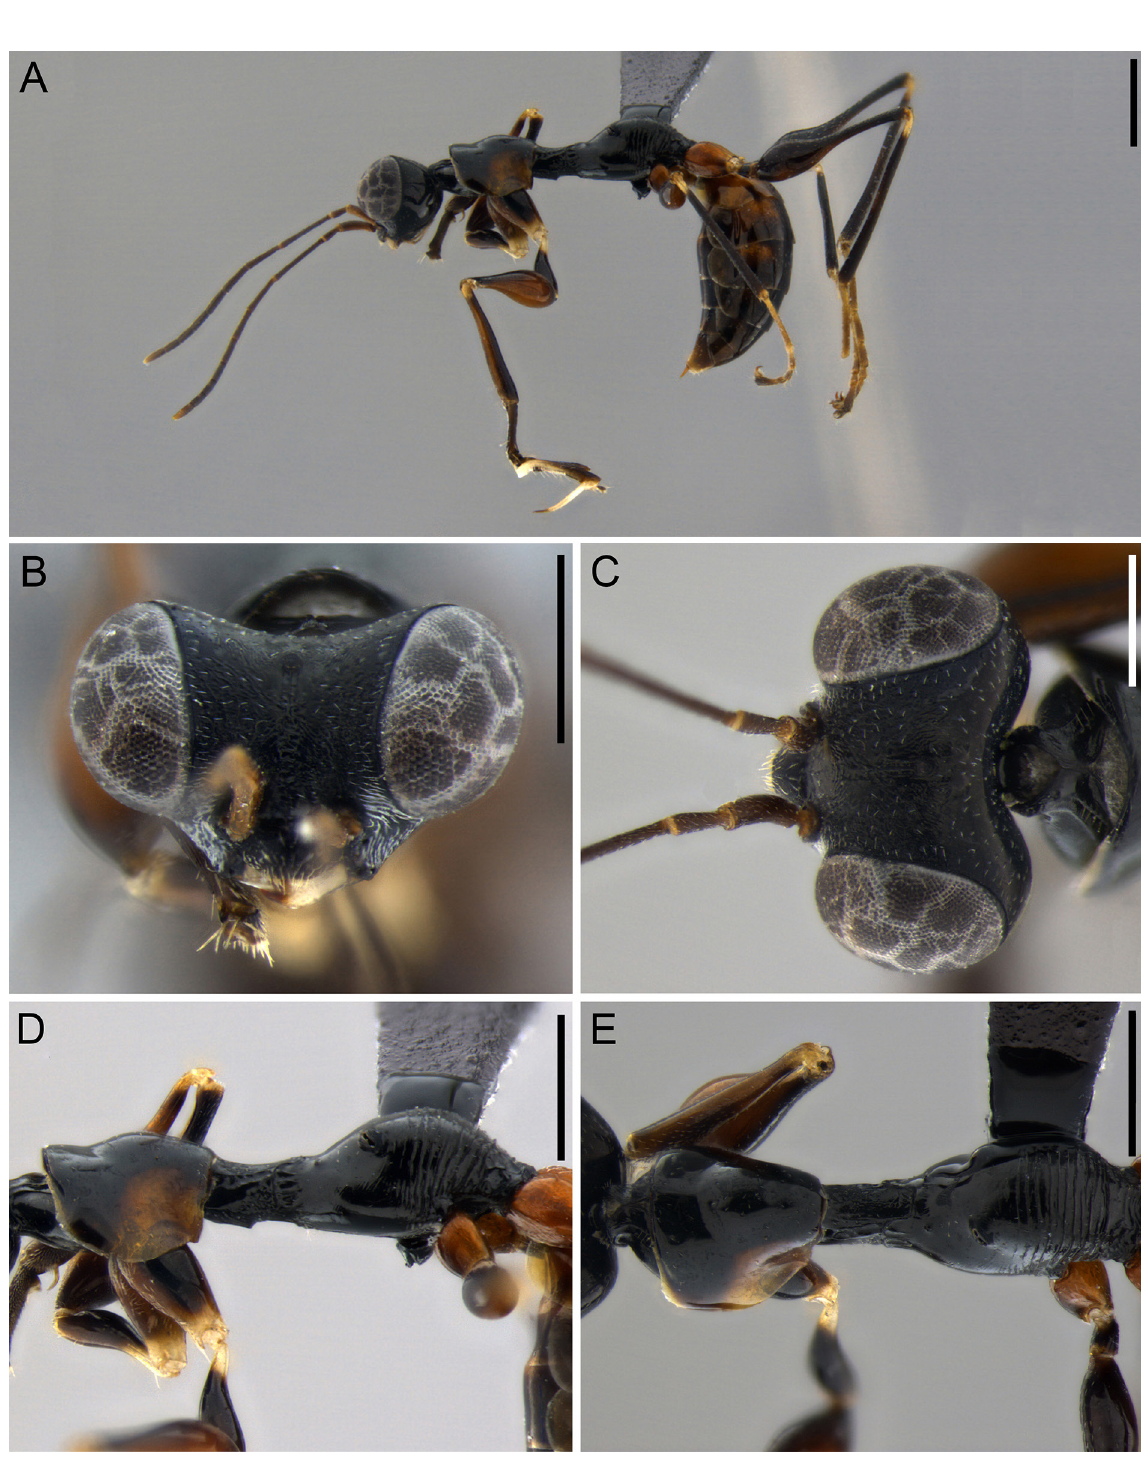
Fig. 6. Pareucamptonyx paranaensis Martins sp. nov., holotype, ♀ (DZUP). A . Habitus, lateral view. B . Head, frontal view. C . Head, dorsal view. D . Mesosoma, lateral view. E . Mesosoma, dorsal view. Scale bars = 1.0